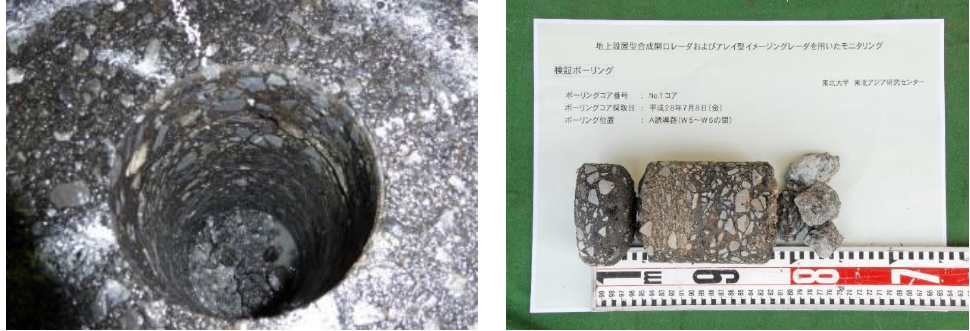
Figure 11. Coring sample acquired from the damaged pavement (x = 6 m) at the Sendai Airport site.